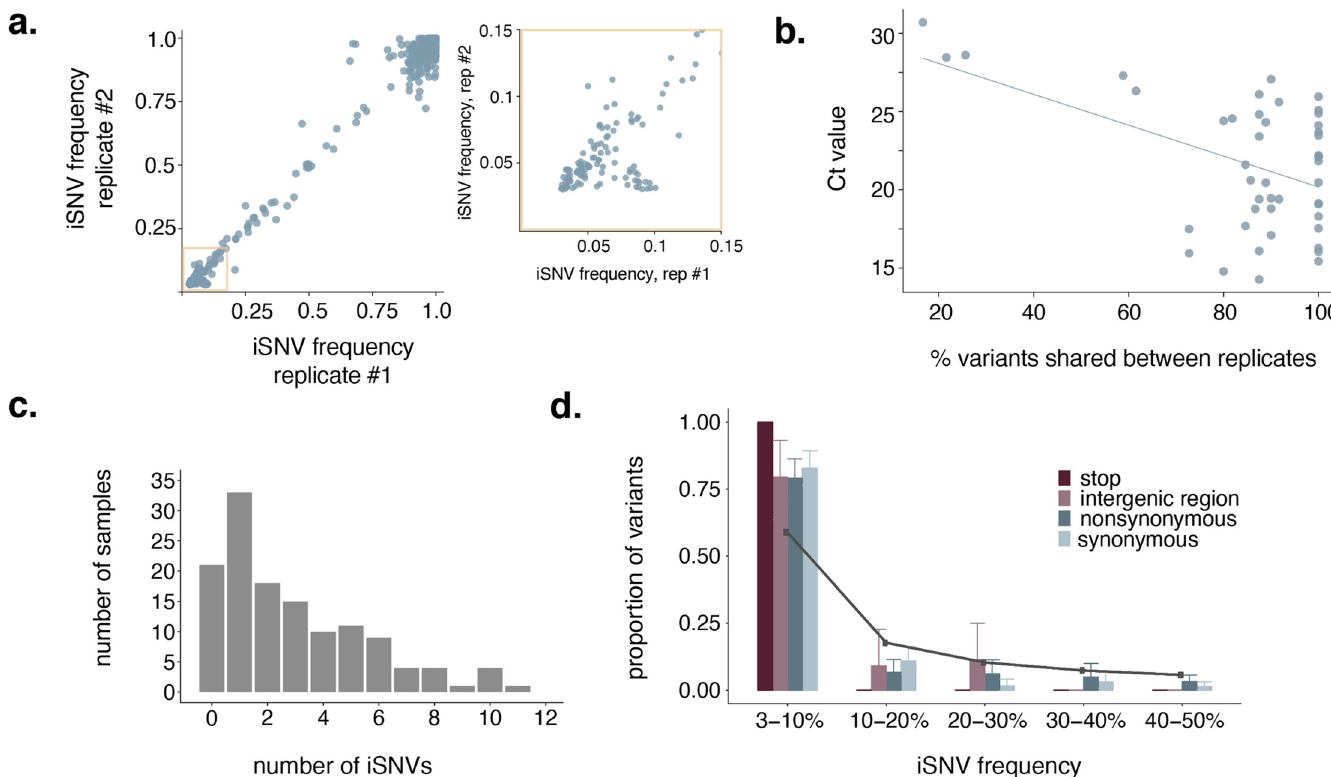
Fig 1. Within host variation is limited after data quality control. a. iSNV frequencies in replicate 1 are shown on the x-axis and frequencies in replicate 2 are shown on y-axis. The yellow box highlights low-frequency iSNVs (3–15%), which is expanded out to the right. b. The Ct value is compared to the percent of iSNVs shared between technical replicates. The blue line is a line of best fit to highlight the observed negative trend. c. Distribution of the number of total iSNVs detected per sample. 22 out of 133 samples harbor no iSNVs at all, and the maximum number of iSNVs in a single sample was 11. d. The proportion of iSNVs that were detected at various within-host frequency bins is shown. Error bars represent the variance in the proportion of total within-host iSNVs within that frequency bin across samples in the dataset as calculated by bootstrapping. There was a single stop variant in the entire dataset, so no error bar is shown for the stop category. The solid grey line indicates the expected proportion of variants in each frequency bin under a neutral